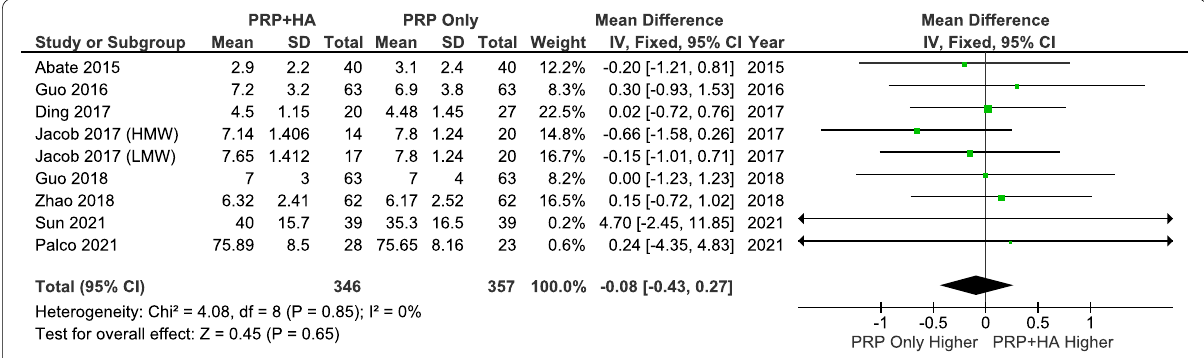
HA and PRP at baseline +